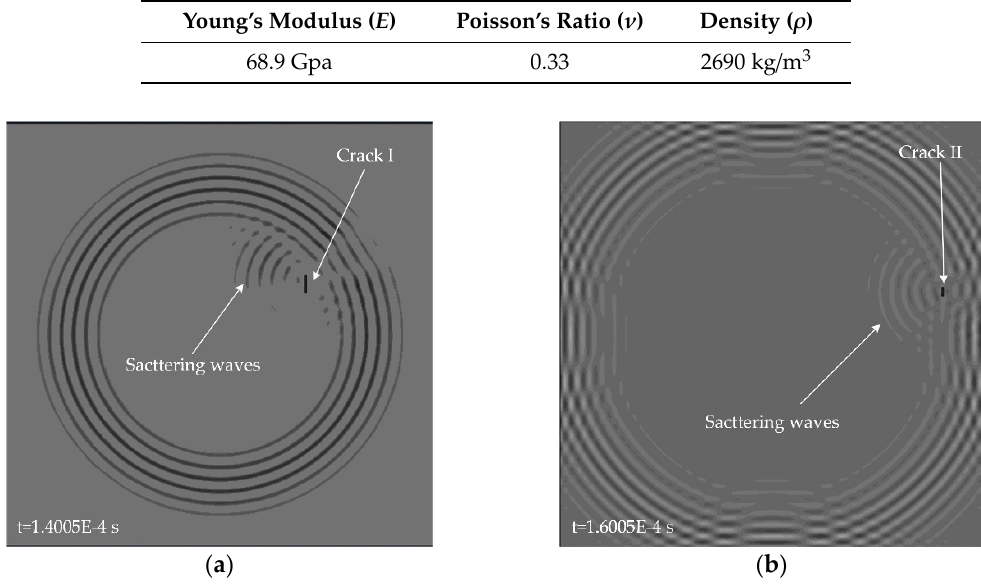
Figure 3. Snapshots of A0 mode Lamb wave propagation in an aluminum plate with different cracks: ( a ) crack I with a length of 20 mm and a width of 2 mm (simulation I); ( b ) crack II with a length of 10 mm and a width of 2 mm (simulation II). The excitation source is located on the center of the